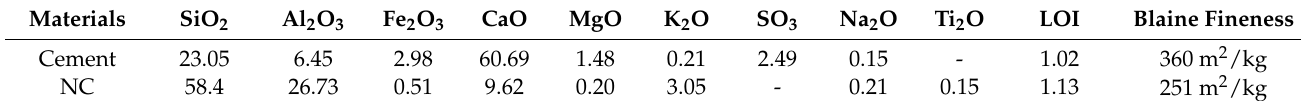
Table 1. Chemical compositions [wt.%] and Blaine fineness of the cement and NC.